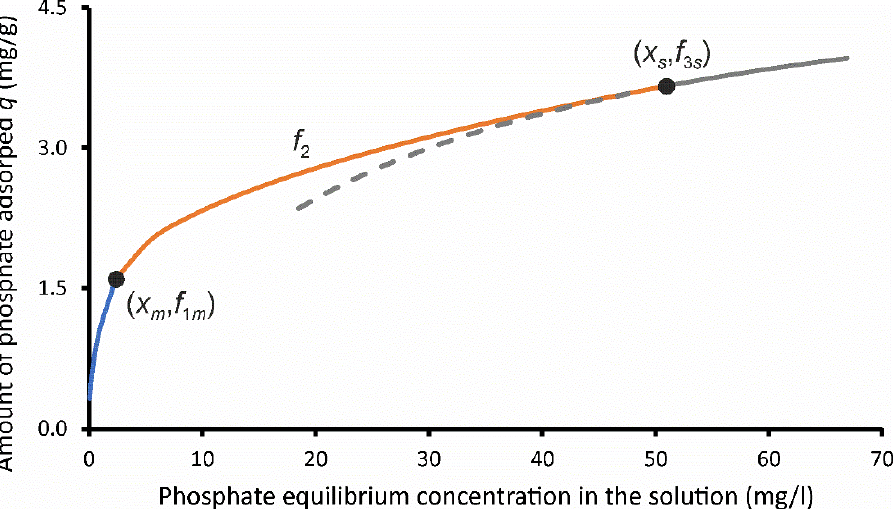
Figure 1. Freundlich isotherm in all concentration ranges. Blue: experimental data [2], grey: saturation regimes according to Equation (4), orange: bridging the chasm for intermediate concentrations.